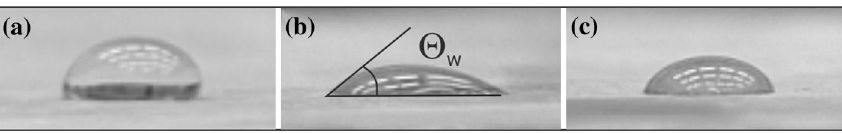
Fig. 5 Measurement of contact angle with distilled water ( h w ) for UHPC with steel fiber (0.25%) and polypropylene fiber (0.75%), with granite aggregate: a before frost resistance test, t = 0 min, b before frost resistance test, t = 35 min, c after frost resistance test, t = 0